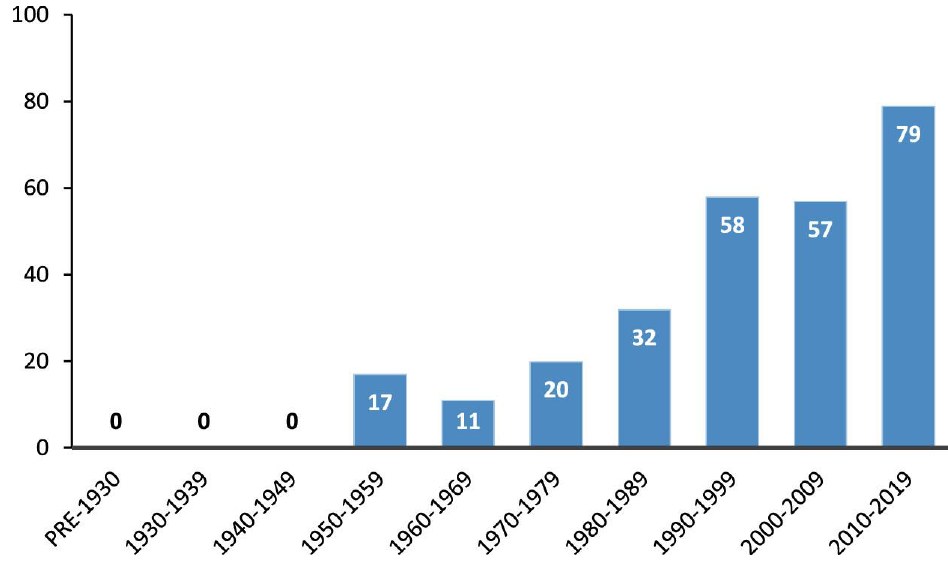
Figure 1. Fluorine-containing drugs being introduced into the market in previous years until 2019. Figure used with permission from [3]. Copyright 2020 American Chemical Society.